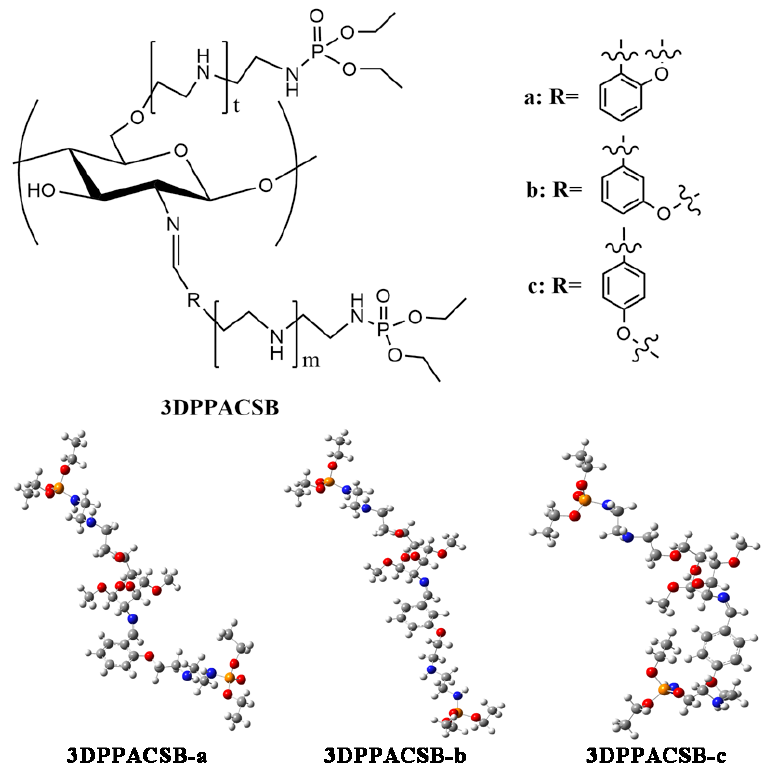
Figure 1. Molecular structure and unit geometry model of several phosphorylated chitosan deriva- tives (3DPPACSB: diethoxyphosphoryl polyaminoethyl chitosan Schiff Table 2. Antifungal properties of some phosphorylated chitosan derivatives. Sample